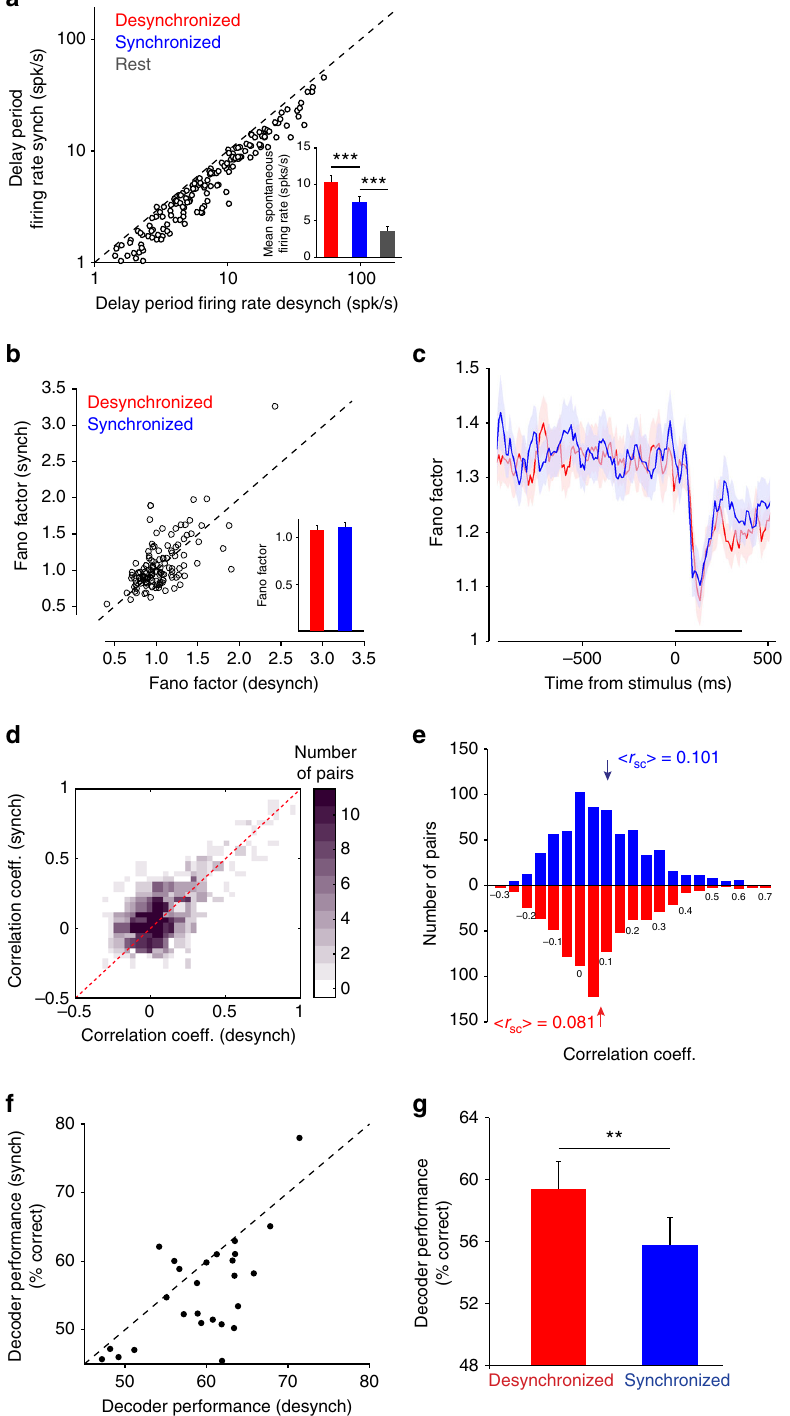
Fig. 2 Cortical state impacts the ability of the population of cells to extract sensory information. a Firing rates are higher in the desynchronized cortical state. The scatter plot pools data across sessions (each circle represents one neuron). Inset, mean fi ring rates of neurons in desynchronized and synchronized trials (*** P < 0.0001). b Fano factor (variance/mean) in the synchronized states plotted as a function of Fano factor in the desynchronized state for the test stimulus presentation. Inset, average Fano factor for each state ( P > 0.05). c Fano factor plotted in a 50ms sliding window (step size 10ms) for the 1 s before test stimulus presentation (black bar) to 500 ms past stimulus onset. d Three-dimensional histogram of the correlation coef fi cients plotted for the synchronized and desynchronized states. The z axis represents the number of pairs in each correlation coef fi cient window. The dotted red line represents unity. e Histogram of the evoked correlation coef fi cients for the synchronized and desynchronized trials. The arrows represent the mean < r sc > for each group. f Scatter plot of decoder performance (% correct classi fi cation) in the synchronized vs. desynchronized state. Each circle represents a session. g Average decoder performance was signi fi cantly higher in the desynchronized state (** P < 0.005). Error bars represent standard